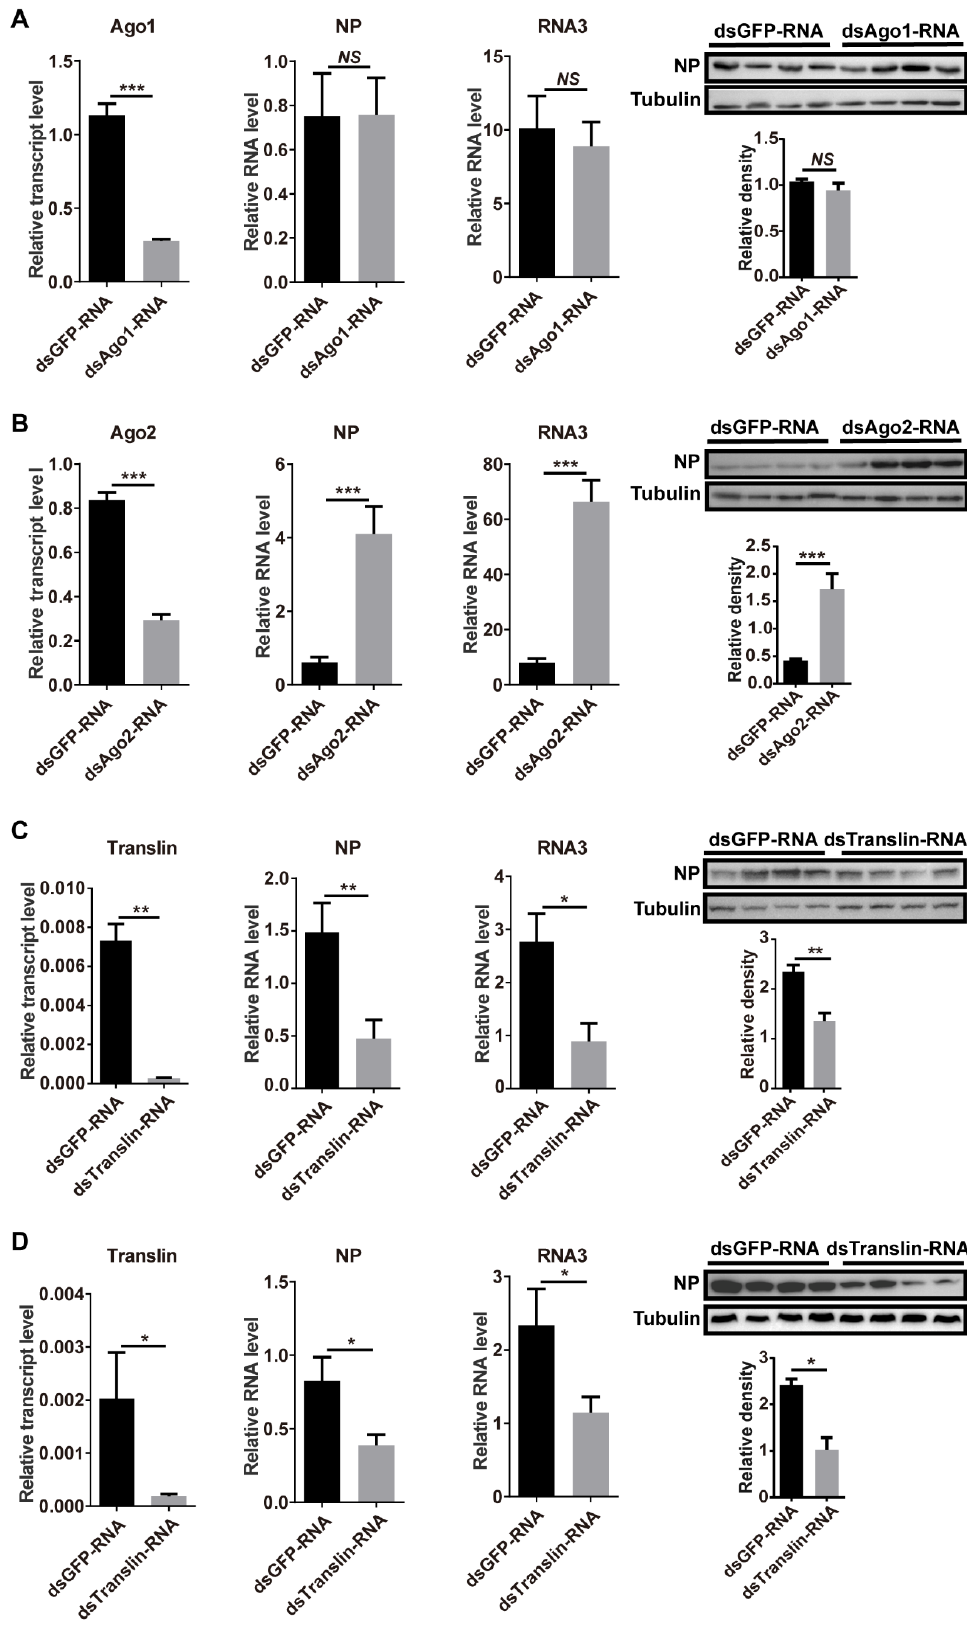
Figure 3. Roles of miRNA and siRNA pathways in the control of RSV replication. ( A – C ) Effect of planthopper Ago1 , Ago2 , and Translin transcript levels, and viral NP and RNA3 levels at 6 d